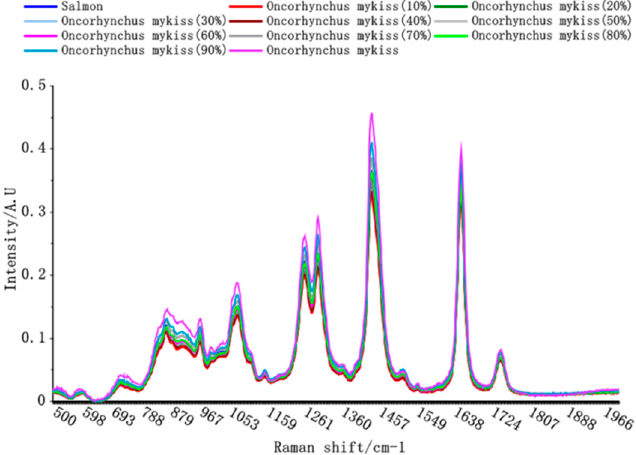
Figure 2. The Raman spectra observed in case of different proportions of rainbow trout adulteration in Atlantic salmon.